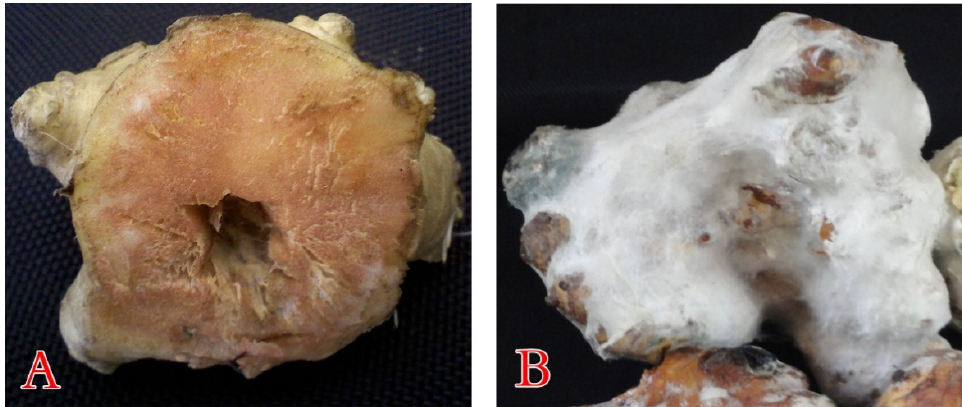
Figure 5. Artificially infected JA tubers with P. polonicum ARS20, showing the healthy ( A ) and the typical symptoms of blue mold ( B ) on tubers.